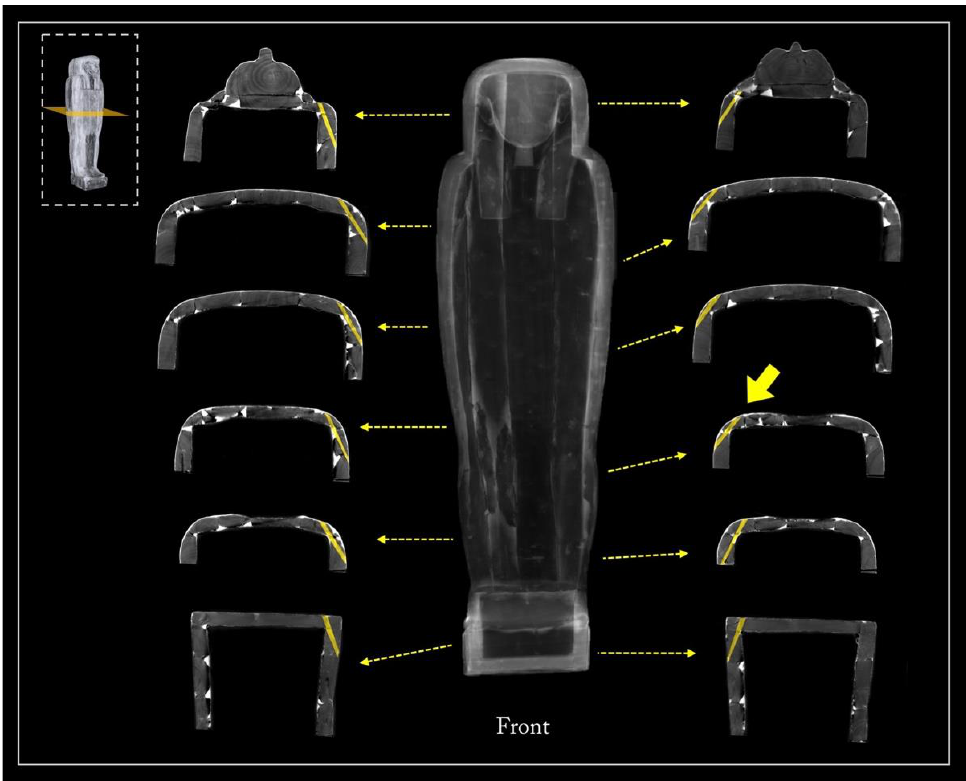
Figure 20. Axial sections showing the joint of the left and right side planks to the front of the lid by means of numerous dowels (in yellow). The arrow indicates the insertion direction of the dowels.